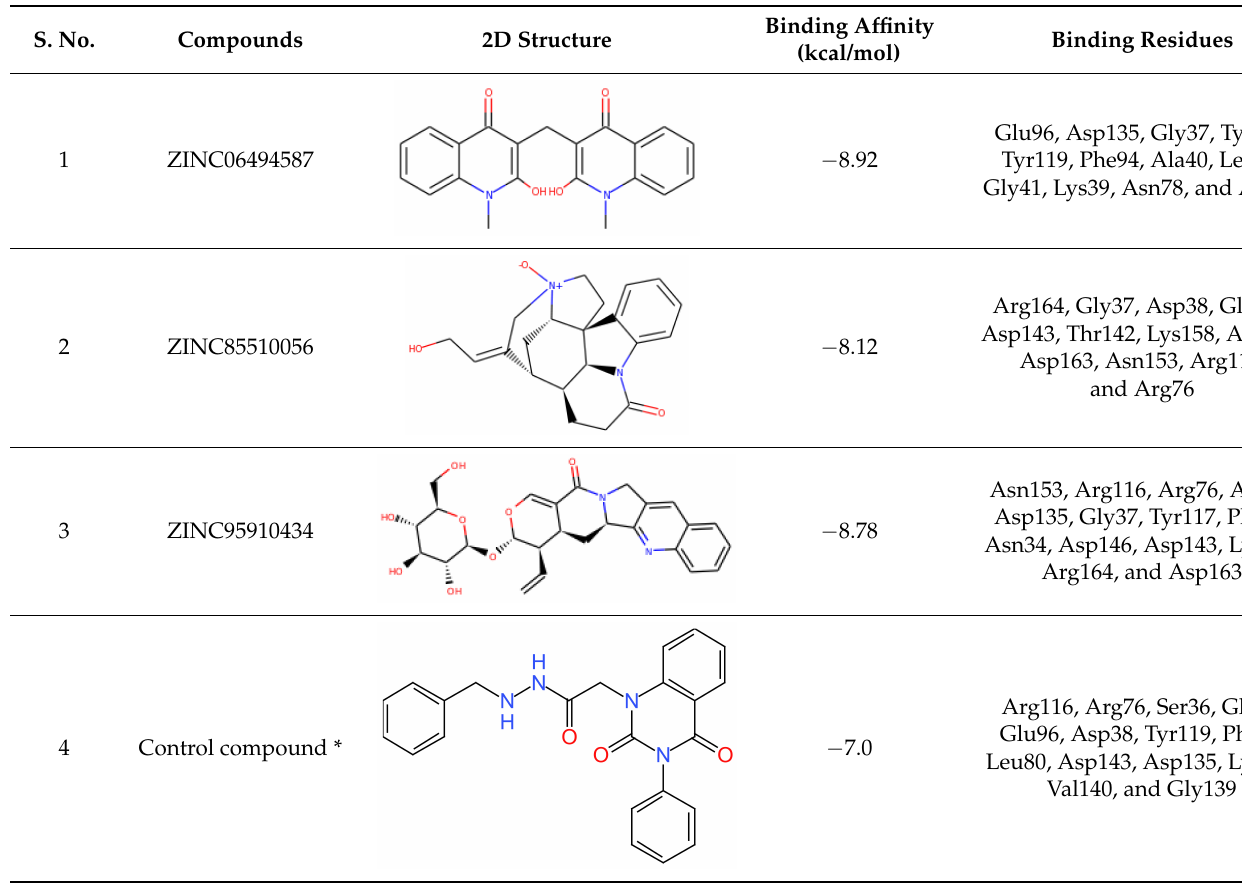
Figure 4. Visualization of ZINC95910434 in the binding pocket of OmpU ( a ); 2D view of residues of OmpU interacting with ZINC95910434 ( b ). Table 3. Binding affinity values of leads with the OmpU